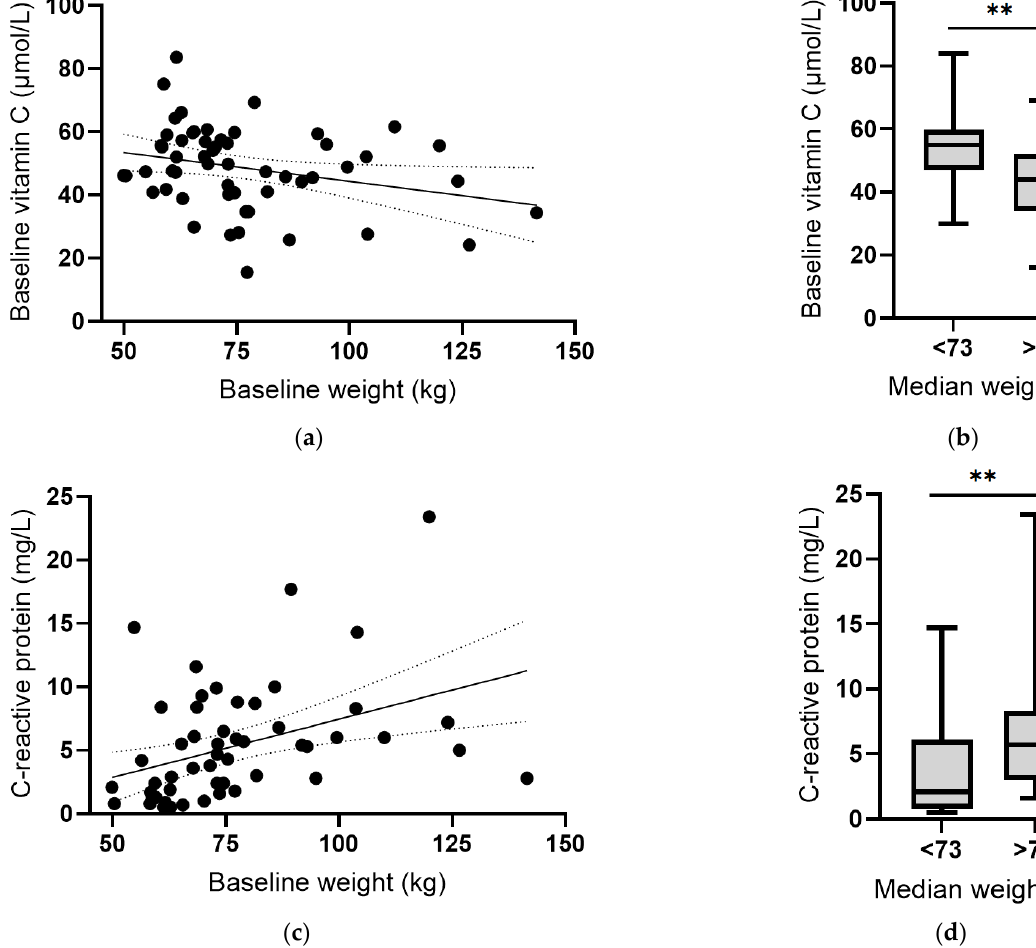
Figure 6. Vitamin C and C-reactive protein concentrations relative to body weight. ( a ) Inverse correlation between vitamin C status and weight ( r = − 0.287, p = 0.03). ( b ) Vitamin C status relative to median body weight (** p = 0.001). ( c ) Positive correlation between CRP and weight ( r = 0.501, p = 0.0001). ( d ) CRP concentration relative to median body weight (** p = 0.004). Dashed lines indicate 95% confidence intervals. Box plots represent median with 25th and 75th percentiles as boundaries, and whiskers indicate maximum and minimum values.